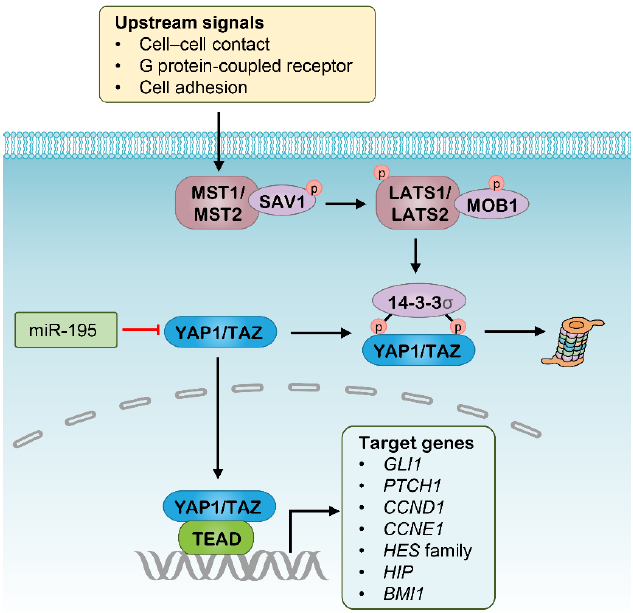
Figure 3. The Hippo signaling pathway and potential RNAi targets. MST, Macrophage stimulating; SAV1, Salvador homologue 1; LATS, Large tumor suppresser kinase; MOB1, MOB domain kinase activator 1; YAP1, Yes-associated protein 1; TAZ, WW domain containing transcription regulator 1; TEAD, TEA domain.